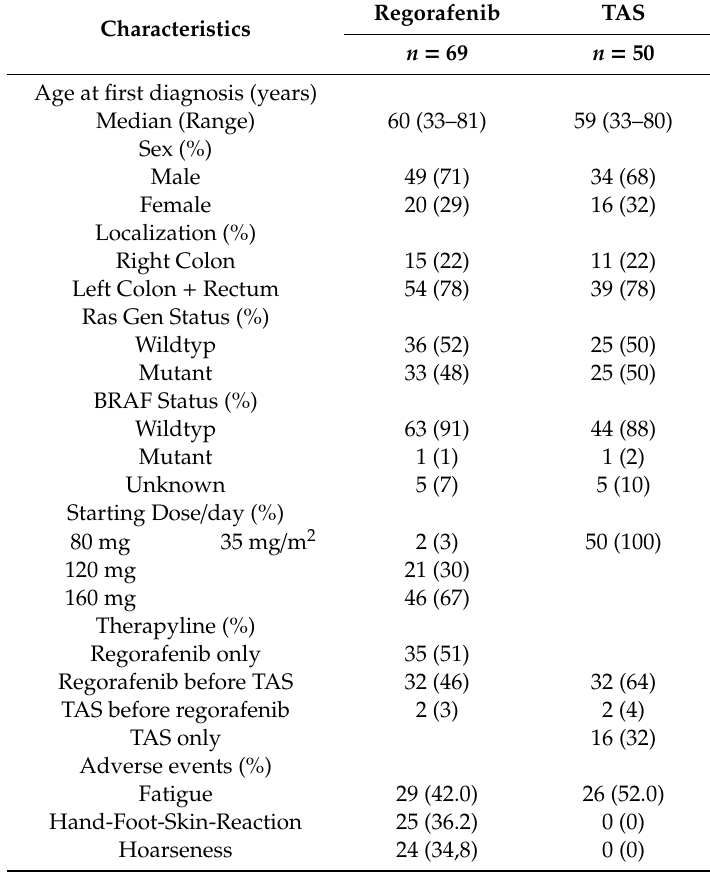
Table 1. Baseline patient characteristics and adverse events (CTCAE any